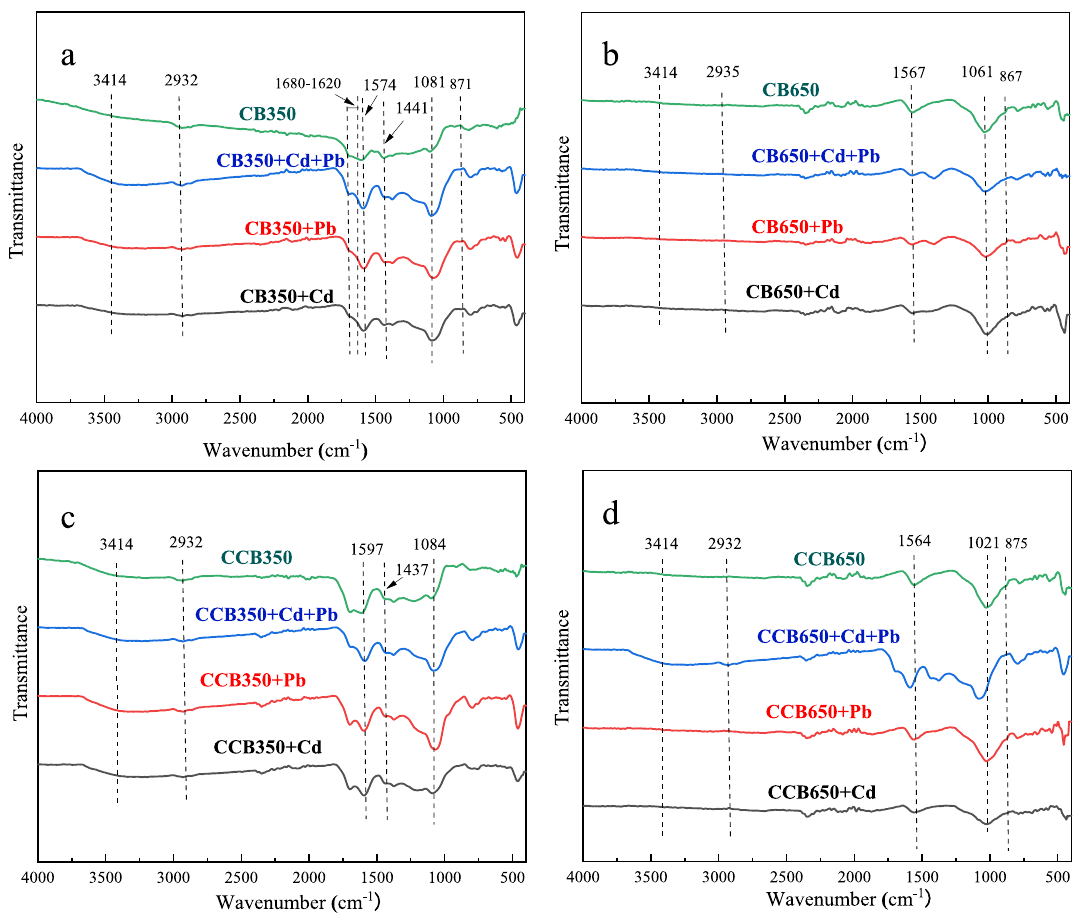
Figure 5. FTIR spectra of biochars before and after reaction with Cd 2+ and Pb 2+ in the single and binary systems ( a ) for CB350, ( b ) for CB650, ( c ) for CCB350, and ( d ) for